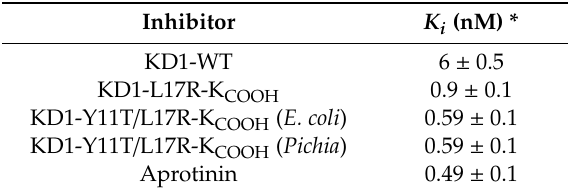
Figure 3. ( A ) Determination of equilibrium dissociation constants ( K i ) of E. coli expressed KD1-WT (IIa cleavage site, 32), E. coli expressed KD1-L17R-K COOH , KD1-Y11T/L17R-K COOH with enterokinase cleavage sites, P. pastoris expressed KD1-Y11T/L17R-K COOH and aprotinin with plasmin. The enzyme activity is expressed as the percent fractional activity (inhibited rate/uninhibited rate) at increasing inhibitor concentrations. The inhibition constants ( K i ) were determined using equations 1 and 2 as outlined in the Experimental section. The data represent average of three experiments. The concentration of plasmin used was 3 nM. ( B ) Inhibition profile of KD1-Y11T/L17R-K COOH with FVIIa/sTF, pKLK and FXIa. The concentration of FVIIa/sTF was 20 nM, whereas pKLK and FXIa were 1 nM each. No inhibition was observed up to 3 µM concentration of KD1-Y11T/L17R-K COOH in the triplicate experiments performed. Table 1. K i values for inhibition of plasmin by KD1-WT, KD1-Y11T-K COOH, KD1-L17R/Y11T-K COOH and aprotinin.